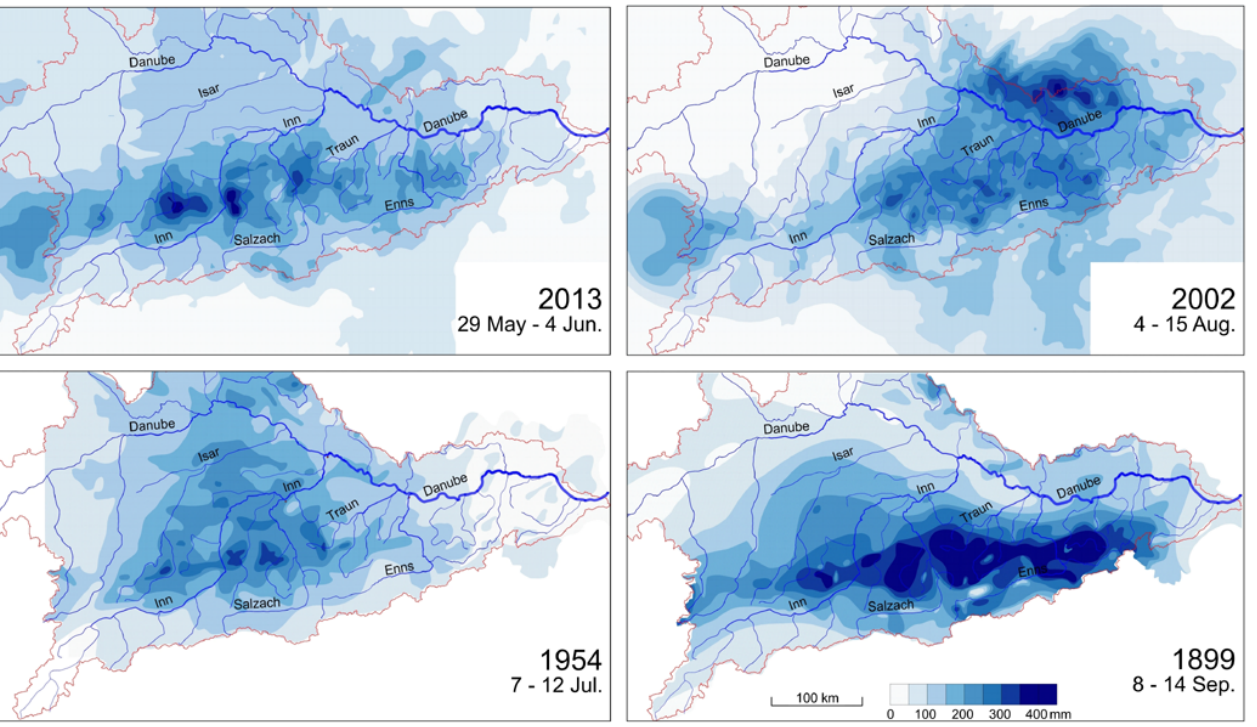
Fig. 4. Observed precipitation totals of four large flood events in the Upper Danube Basin: 29 May 00:00 to 4 June 2013 24:00; 4 August 00:00 to 15 August 2002 24:00; 7 July to 12 July 1954, and 8 September to 14 September 1899 (based on available daily records, 07:00 to 07:00). 2013 and 2002 are based on rain gauge data interpolated by the INCA method using radar (Haiden et al., 2011). 1954 and 1899 are based on rain gauge data interpolated manually from about 600 stations within the Danube Basin (HZB, 1955; Lauda, 1900). Red line indicates the Upper Danube catchment boundary above